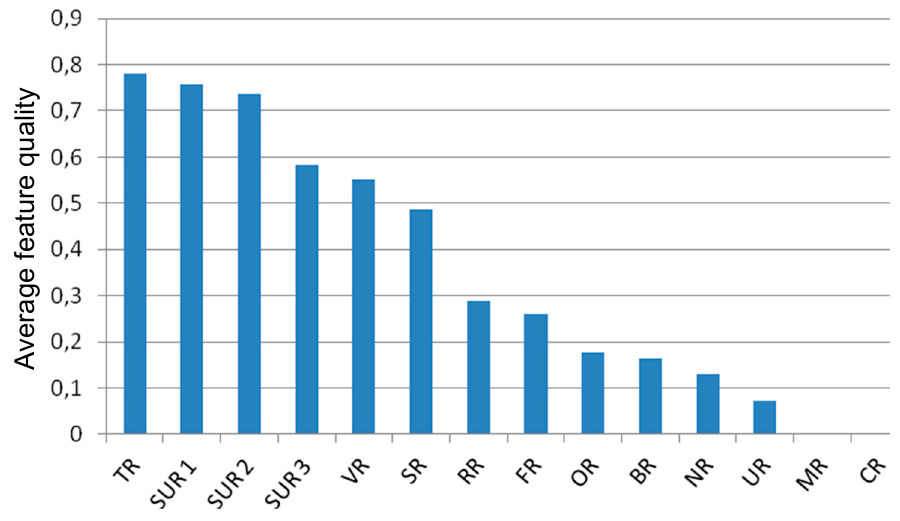
Figure 6. Final feature importance.